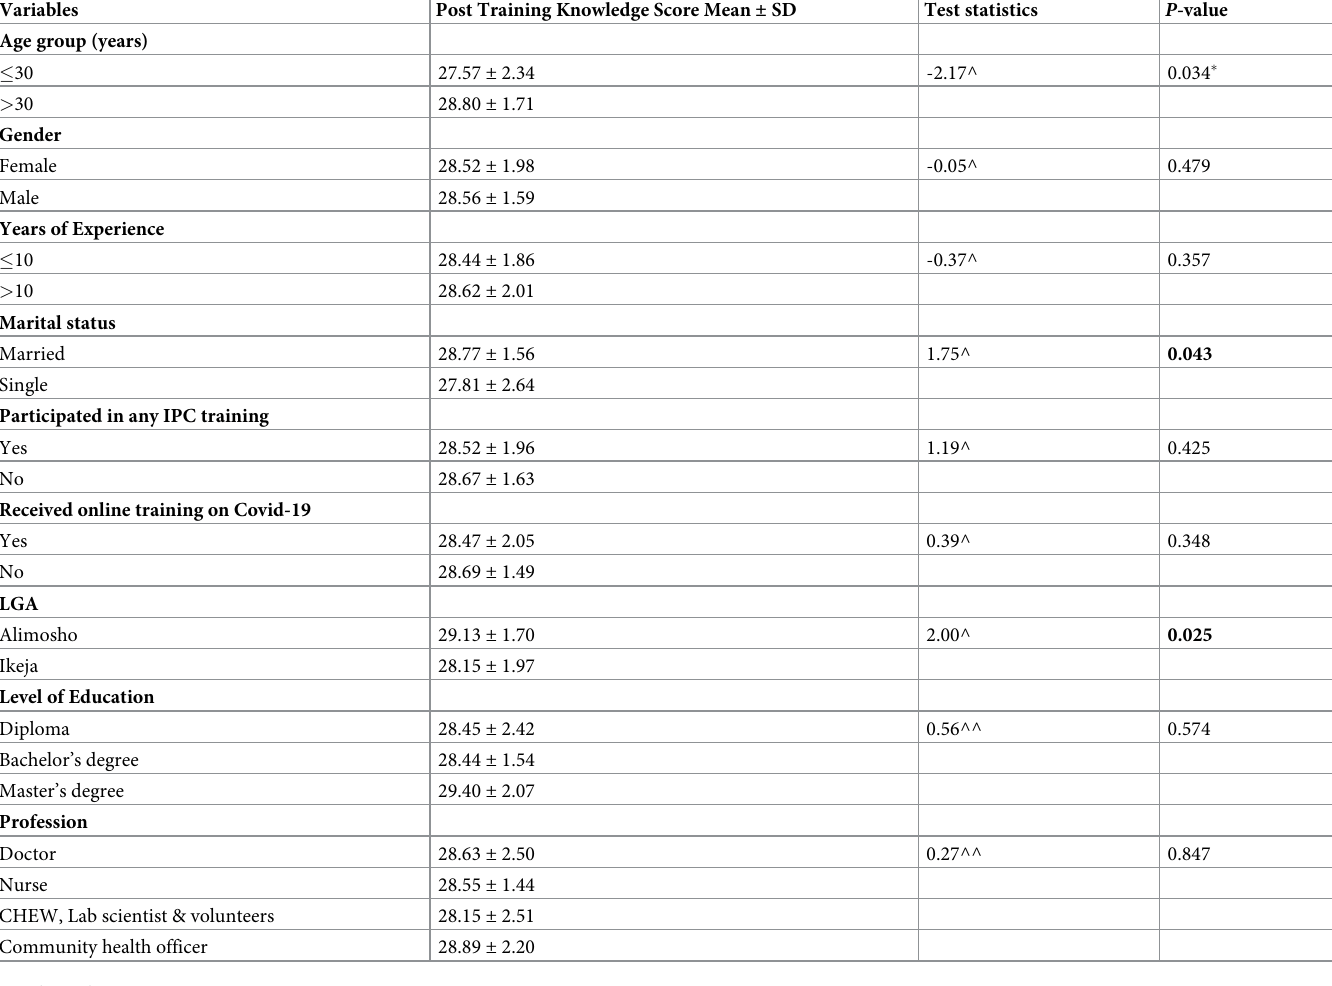
Table 4. Association between PHC workers’ socio-demographic characteristics and COVID-19 knowledge scores